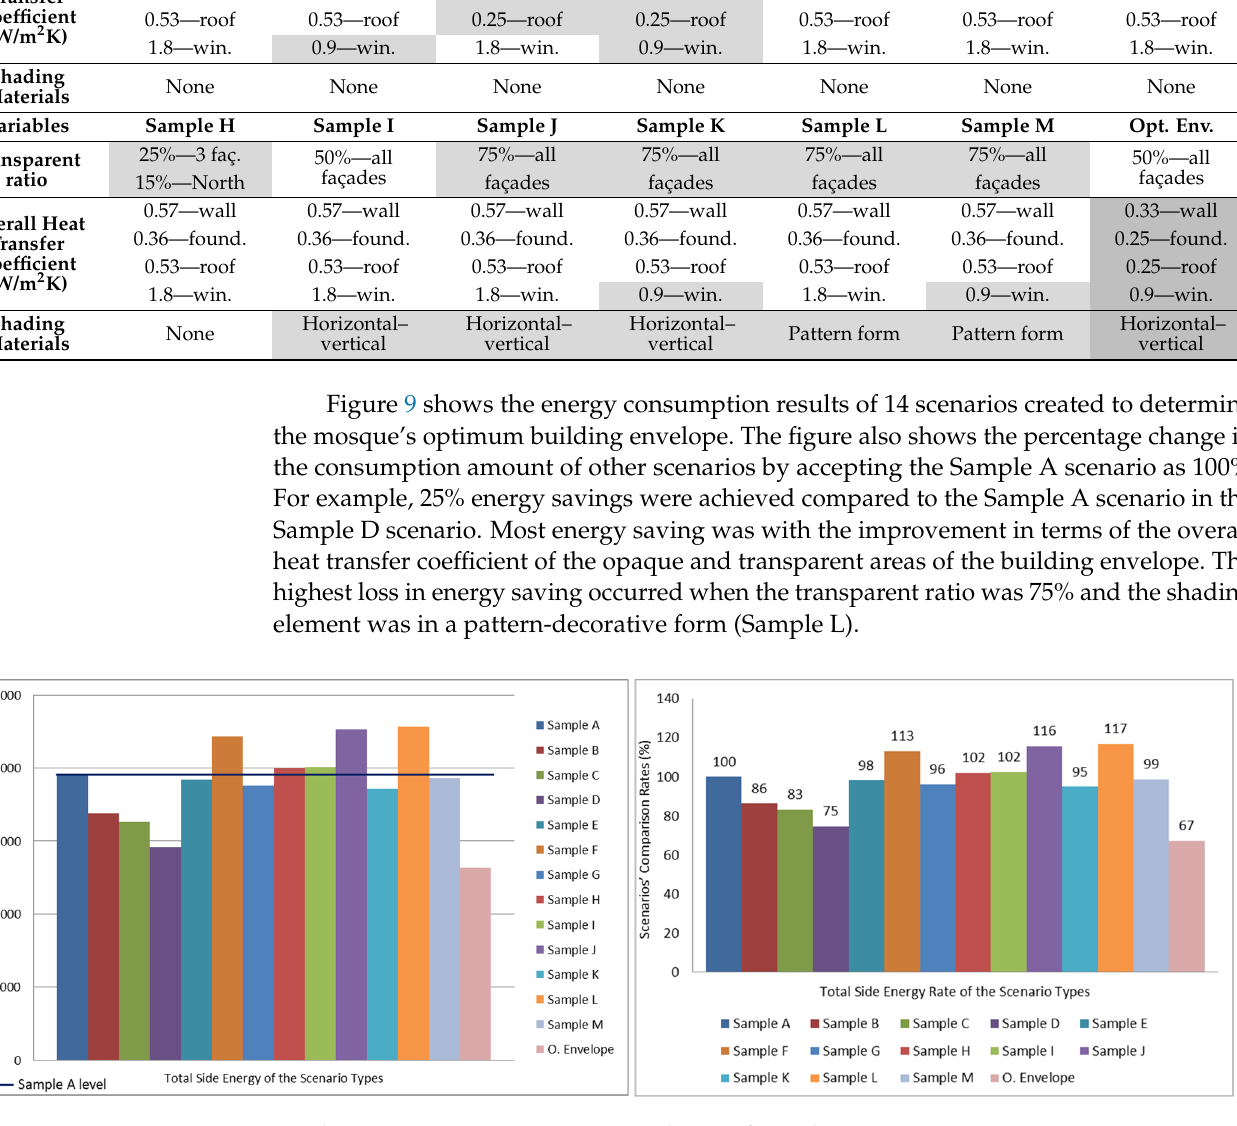
Figure 9. Total energy consumption amounts and rates of sample mosque scenarios. The improvement in the heat transfer coefficient of only the windows of the building envelope with a 50% transparent ratio obtained a similar amount of energy saving with the improvement in the heat transfer coefficient of all opaque areas (Sample B,C). It is one of the best solutions to improve the heat transfer coefficient of opaque and transparent areas together (Sample D). Increasing the transparent ratio of the building envelope caused an increase in energy consumption (Sample F). As a result of reducing the trans- parent ratio, there was not a huge change in energy consumption compared to the base scenario (Sample E). However, reducing the transparent ratio reduced the gain of day- light. In addition, various transparent ratios depending on different directions were an- alyzed. According to the base scenario, there was no large difference in energy con- sumption (Sample G,H). The use of shading elements in the building envelope of the base scenario, together with the improvement in the heat transfer coefficient of the transparent areas, made a huge positive contribution. There was no large difference in energy consumption be- tween the horizontal–vertical shading element and the pattern shading element (Sample J,L). However, the horizontal–vertical shading element provided a greater positive con- tribution in terms of daylight saving and provided more effective visual contact with the outdoor environment. Figure 10 shows the energy consumption amounts of the HVAC system for the scenarios created by changing the building envelope properties. Reducing the overall heat transfer coefficient contributed positively to the heating energy consumption while making a negative contribution in terms of cooling energy consumption. While the use of shading elements had a negative effect on the heating energy, it had a positive effect on the cooling energy. Reducing the transparent ratio according to base scenario increased the energy consumed for heating. However, it reduced the cooling load. Increasing the transparent ratio of the building envelope reduced the energy consumed for heating, while the energy consumed for cooling increased significantly. This situation was re-